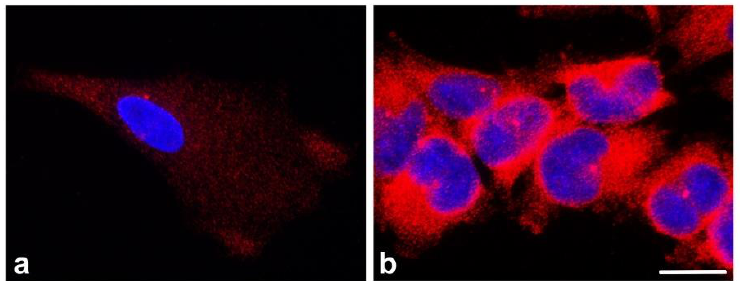
Figure 3. Differential expression and localization of γ -tubulin in human astrocytes and glioblastoma cells. Comparison of γ -tubulin distribution (red) in primary culture of human astrocytes (Lonza CC-2565) ( a ) and human glioblastoma cell line T98G ( b ) using monoclonal antibody TU-30 [19]. Nuclei in blue. Note the abnormal accumulation of γ -tubulin outside centrosomes in glioblastoma cells. Fluorescence images were captured and processed in precisely the same manner. Formaldehyde-fixed samples were extracted with Triton X-100 and postfixed in methanol. Scale bar, 20 μ m.